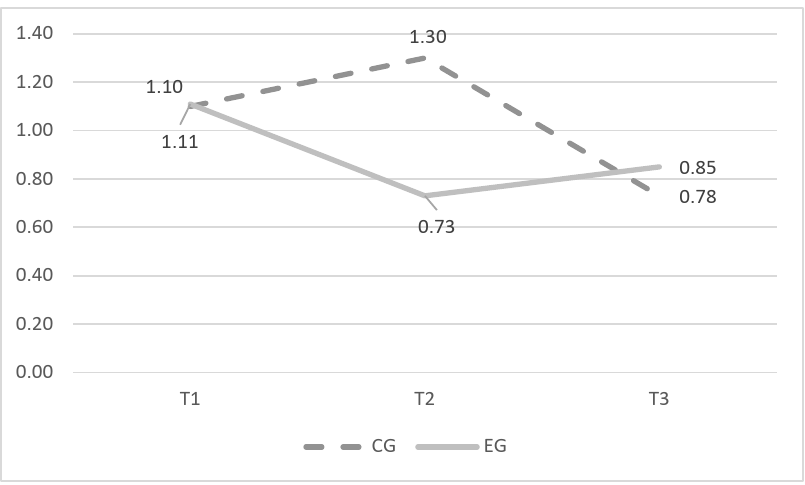
Figure 2. Average scores in cybervictimization over time. 3.2. Long ‐ Term E ff ect of Tabby Improved Prevention and Intervention Program (TIPIP) Examining the long-term effect of the program on cyberbullying, the mixed ANCOVA with a Greenhouse–Geisser correction showed a non-significant group effect ( F (1,442) = 0.063, p = 0.803, η 2 = 0.000), a non-significant time*gender interaction ( F (2,441) = 0.381, p = 0.683, η 2 = 0.002) and a non-signi fi cant group*time interaction ( F (2,441) = 0.337, p = 0.683, η 2 = 0.002). A similar pattern of results was found for cybervictimization, mixed ANCOVA’s results indicated a non-significant group effect ( F (1,442) = 0.558, p = 0.455, η 2 = 0.001), a non-significant group*time interaction ( F (2,441) = 0.821, p = 0.441, η 2 = 0.004) and a non-significant time*gender interaction ( F (2,441) = 0.082, p = 0.921, η 2 = 0.000). However, looking at average scores (Table 3) over time, there is a decrease both in CB and CV at T2 for students in the EG. Table 3. Mean and standard deviations of cyberbullying and cybervictimization across conditions over time. T1 T2 0.73 (1.77) 4. Discussion The main aim of the present study was to evaluate the long-term e ff ect of the Tabby Improved Prevention and Intervention Program [38] for cyberbullying and cybervictimi- zation in a sample of middle and high school Italian students. Research on cyberbullying [6,13,28,37,46,47] has supported the development and im- plementation of multi-component anti-cyberbullying educational programs with a solid theoretical framework. Since the pervasive nature of cyberbullying and its enormous im- pact on youth mental health [48] and the social and public health burden [8], primary prevention activities should adopt a wider approach in order to target, as well as cyber- bullying and cybervictimization, other phenomena linked to peer aggressive behaviors.